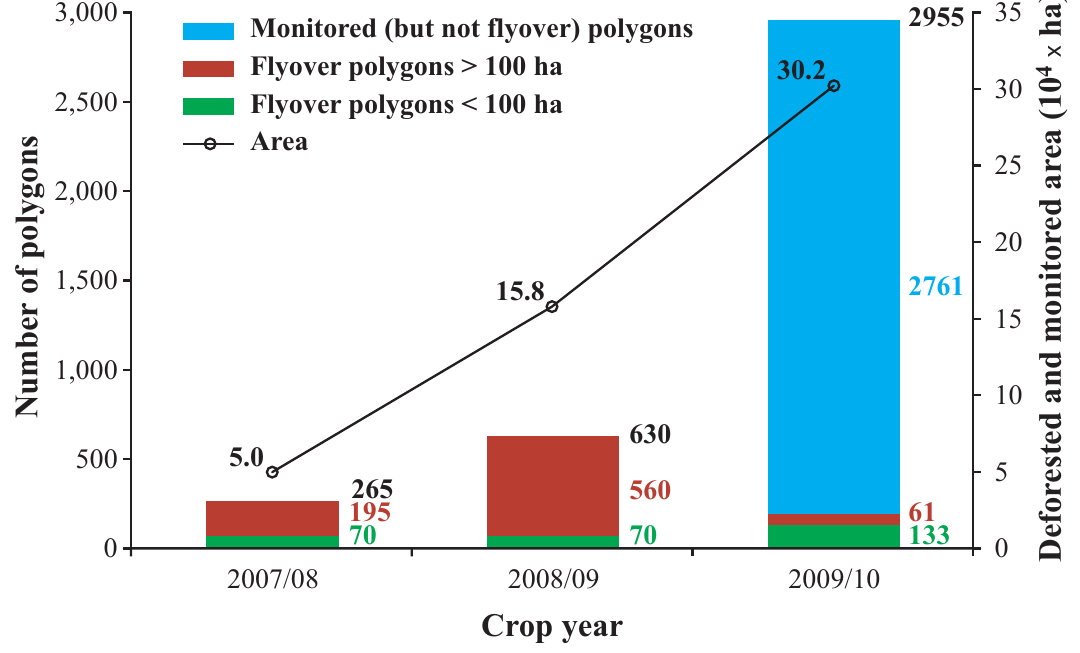
Figure 6. Comparison of three years of Soy Moratorium